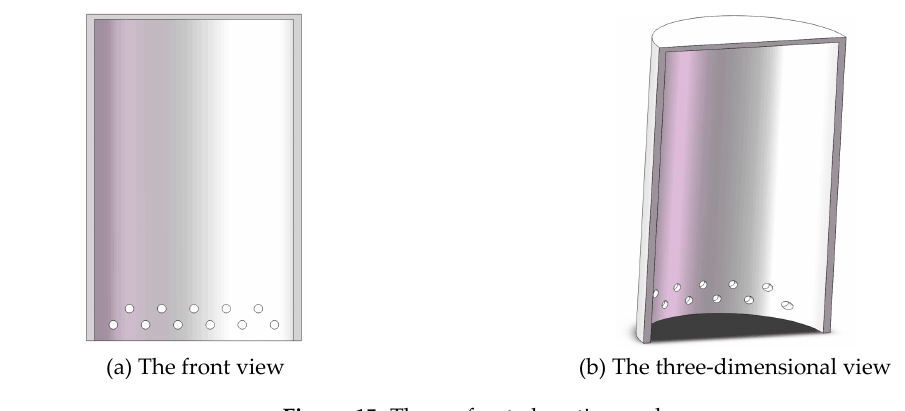
Figure 16. Comparison of residual pore pressure distribution between the traditional anchor and the perforated anchor.